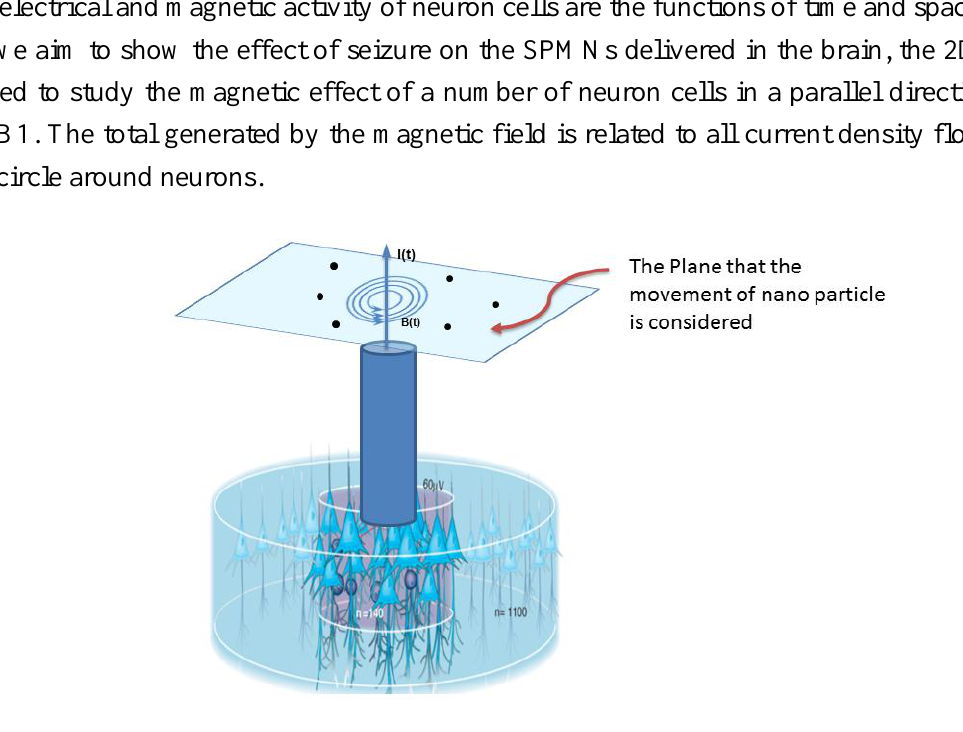
Figure B1. Schematic of 2D analysis of motion of nanoparticles (Nanoparticle movement is considered in y and z plane).